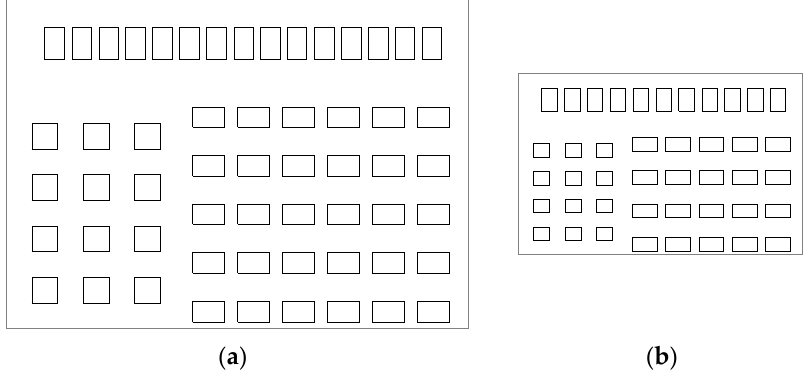
Figure 10. Typifying a façade whose windows are not evenly distributed in both directions: ( a ) original façade which can be composed of several segments; ( b ) Typified for scale reduced by 2×.